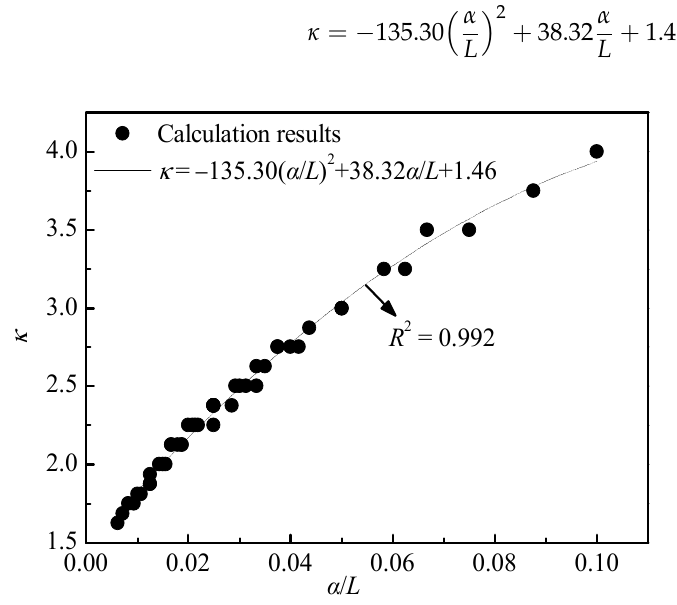
Figure 11. Relationship between unit consumption ( κ ) and the ratio of dispersion to length ( α / L ).